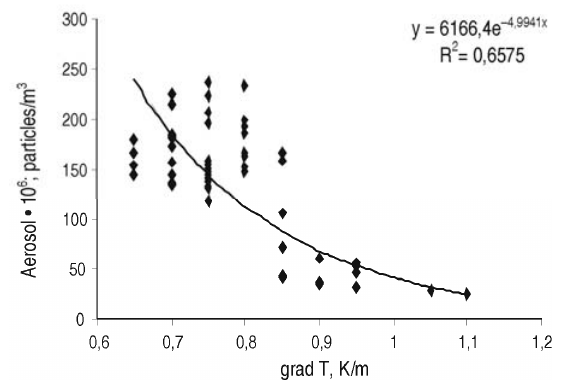
Fig. 8. Relationship between aerosol particle concentra- tion and temperature